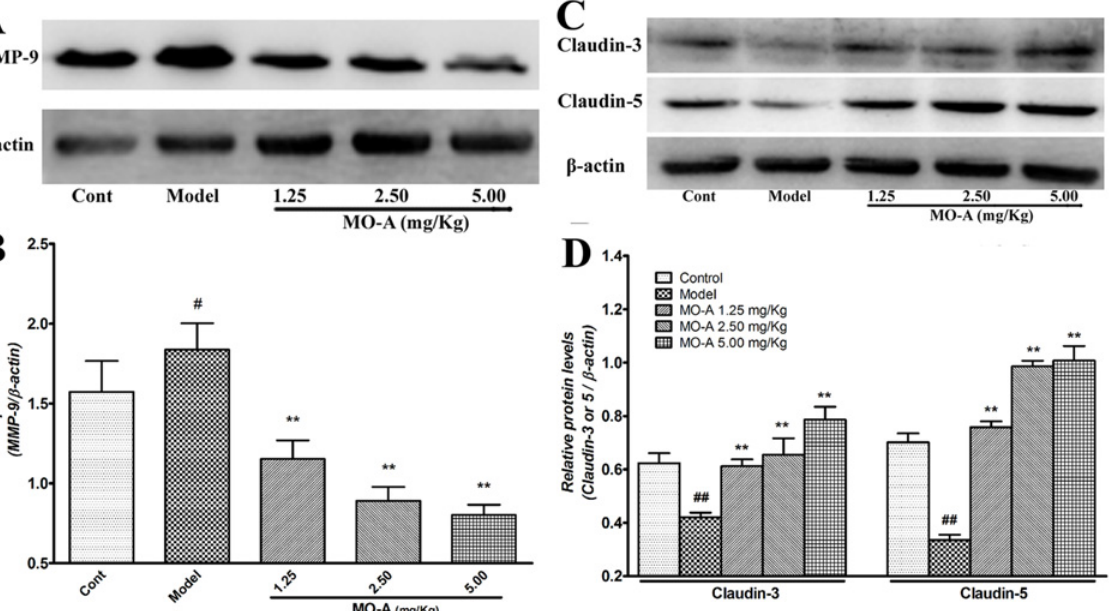
Fig 4. Effect of MO-A on the expression of MMP-9 and tight junction proteins after MCAO in rats. (A) Representative blots of MMP-9 determined by Western blotting; (B) Quantitative analysis of the ratio of MMP-9; (C) Representative blots of claudin-3 and claudin-5 determined by Western blotting; (D) Quantitative analysis of the ratio of claudin-3 and claudin-5; Data are given as mean ± S.D. (n = 3); # P < 0.05 and ## P < 0.01 vs . sham group by Student ’ s t - test statistical analysis; * P < 0.05 and ** P < 0.01 vs . MCAO model group by one-way ANOVA statistical